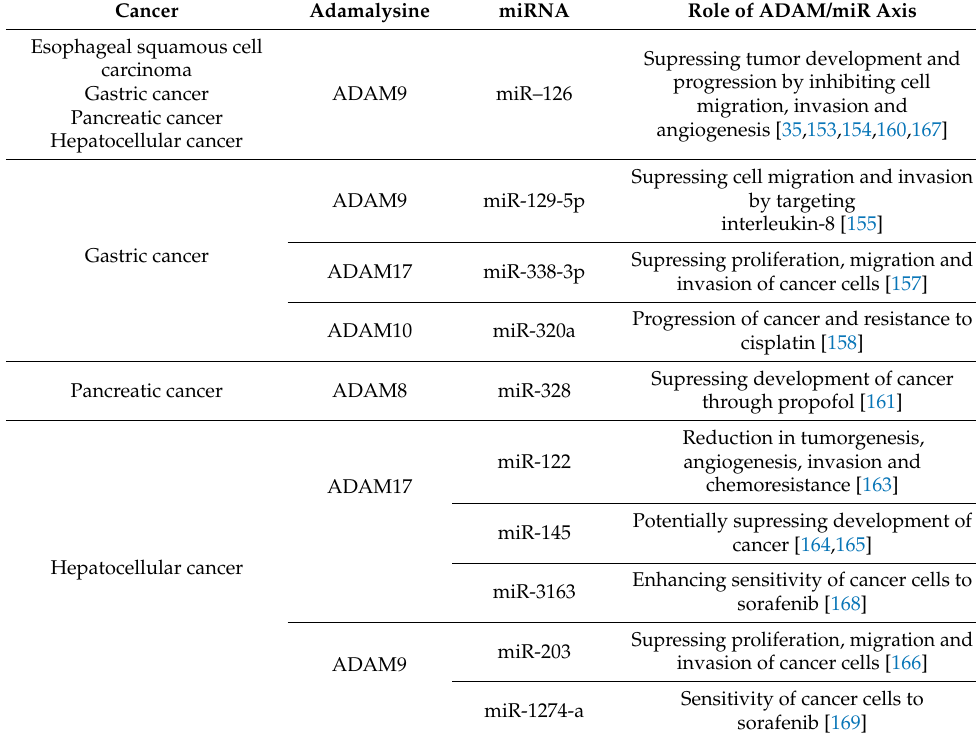
Table 3. The role of ADAM/MiR axes in gastrointestinal cancers. Own